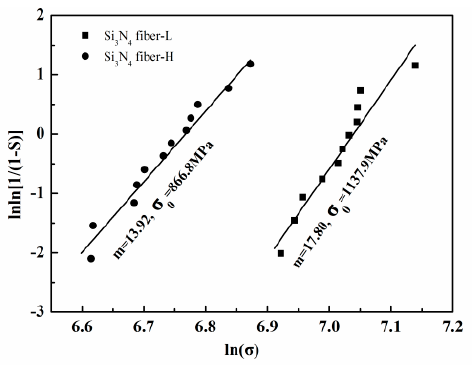
Figure 9. Weibull plots for fiber bundle tests with and without heat treatment.